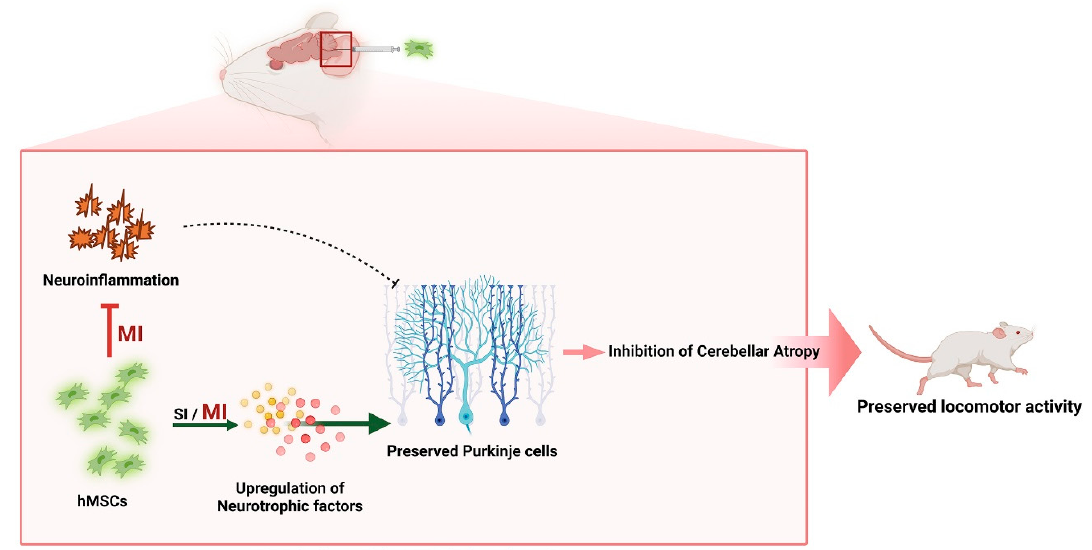
Figure 4. Schematic representation of the effects of hMSCs in the Ara-C-induced CA model. Multiple hMSC treatments significantly improve CA symptoms in the Ara-C-treated mice, and the beneficial effects are attributed to the inhibition of proinflammatory molecules and activation of neurotrophic factors, which prevent cerebellar weight loss and preserve locomotor activity. The figure was created using BioRender.com (Agreement number: HG24TP0M4C). Ara-C, cytosine arabinoside; hMSCs, human mesenchymal stem cells; SI, single injection; MI, multiple injection.